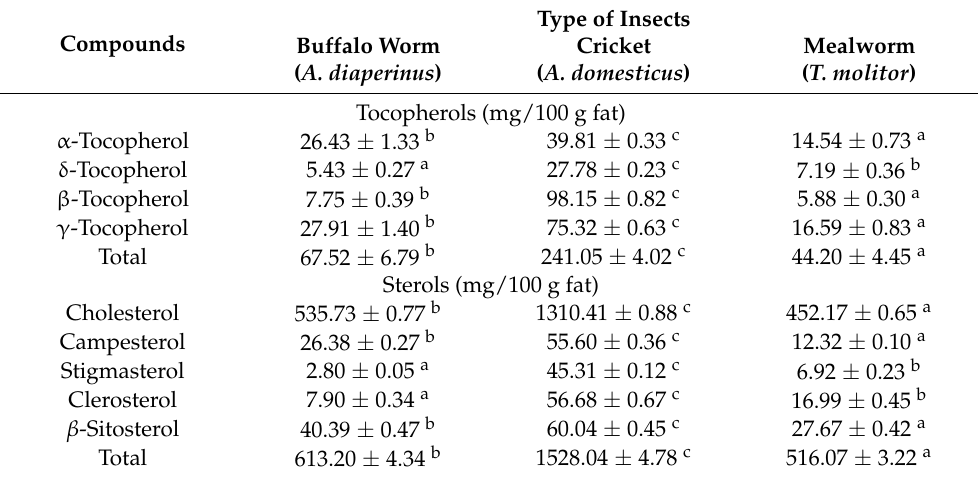
Mealworm ( T. molitor )